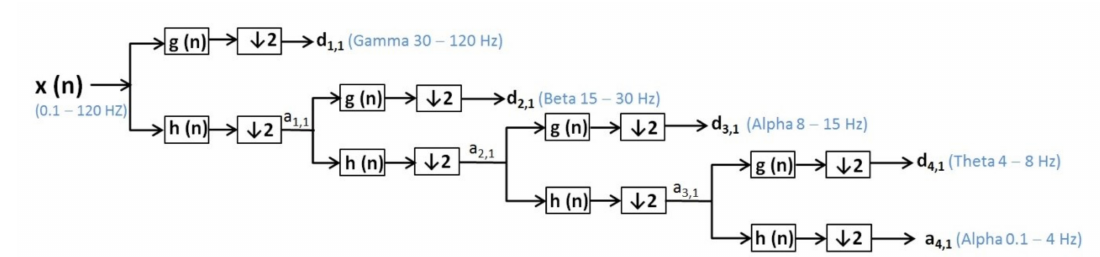
Figure 2. EEG from a patient with epileptic seizure-signal filtering and decomposition using the DWT